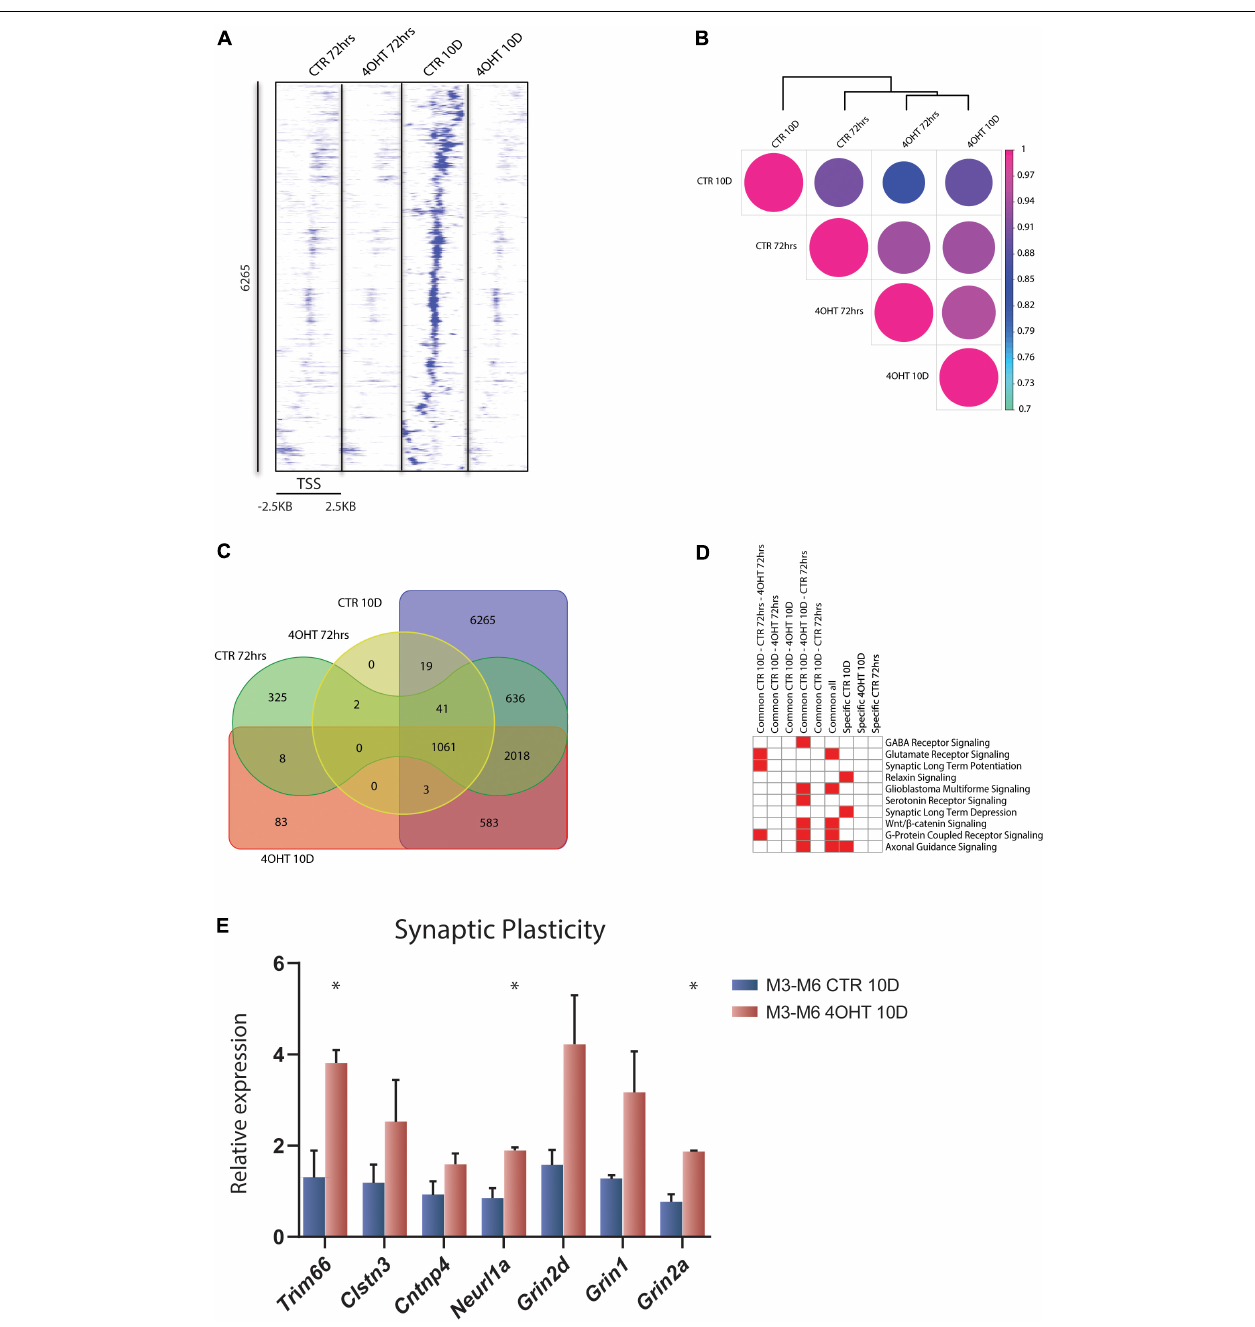
FIGURE 2 | EZH2 impairment causes global loss of the H3K27me3 mark in differentiating neurons. (A) Heat map of normalized tag densities, representing the CTR10D-specific H3K27me3 marked peaks around promoters. Each row represents a 5-kb window centered on the gene TSS and extending 2.5 kb upstream and 2.5 kb downstream. The signal has been generated by merging the bam files of the biological replicates. (B) Correlation matrix plot and hierarchical clustering of the 4-OHT and CTR samples based on H3K27me3 distribution around the TSS. (C) Venn diagram showing the overlap of H3K27me3 enriched peaks around promoters ( ± 2.5kb TSS) between 4-OHT and CTR samples at 72 h and 10D. (D) Heat map showing the top 10 significantly enriched canonical pathways ( p -value < 0.001) related to neuronal function. P -values were computed using IPA software. (E) qRT-PCR validation of selected genes involved in the LTD and NMDA receptor pathways. The experiment was performed on 2 independent neuronal differentiations from 2 independent ESC lines (M3 and M6) (mean ± SEM, unpaired t -test) ( ∗ : p value < 0.05).